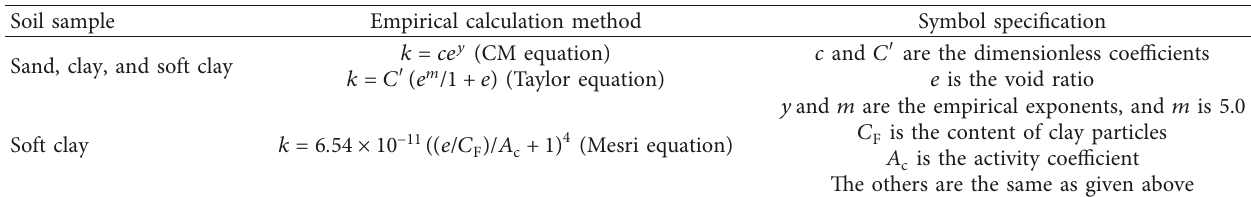
Table 3: Existing empirical calculation methods of the seepage coefficient for clay.